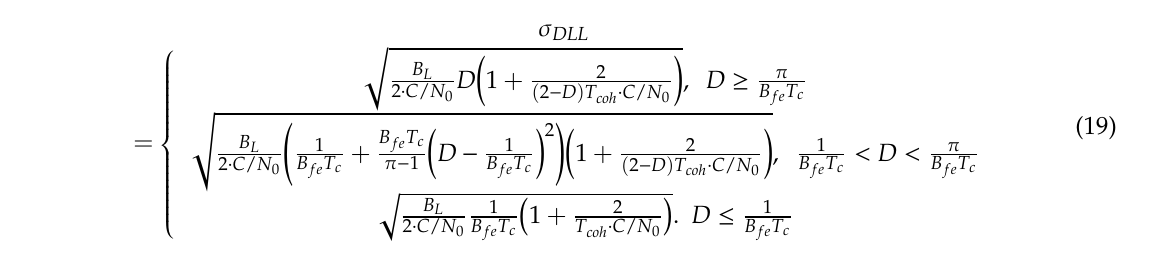
Sensors 2020 , 20 , x FOR PEER REVIEW Algorithm 1: Joint ranging and communication algorithm in distributed spacecraft networks